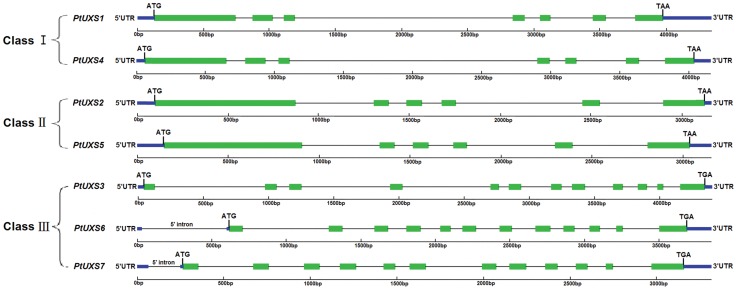
Genomic organization of PtUXSs.Three patterns of intron-exon structures of the PtUXS genes were identified and designated I, II and III. Exons and untranslated regions (UTRs) are shown as green and blue boxes, respectively, and the lines between boxes indicate introns.